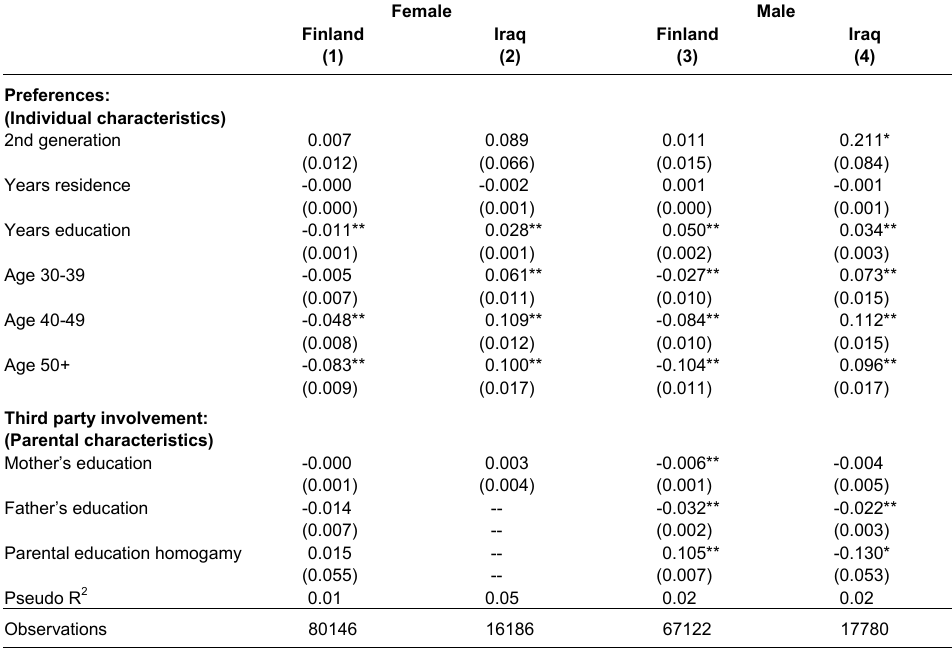
Table 6: The probability of educational homogamy, Finland and Iraq Female Male Finland